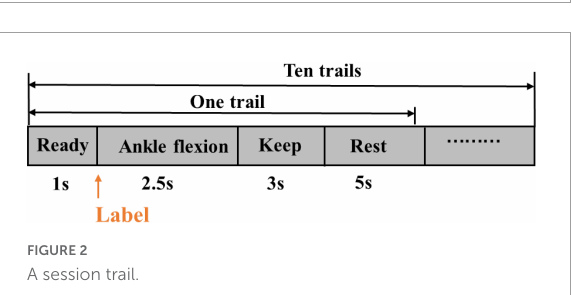
FIGURE1 Experimental scenario.